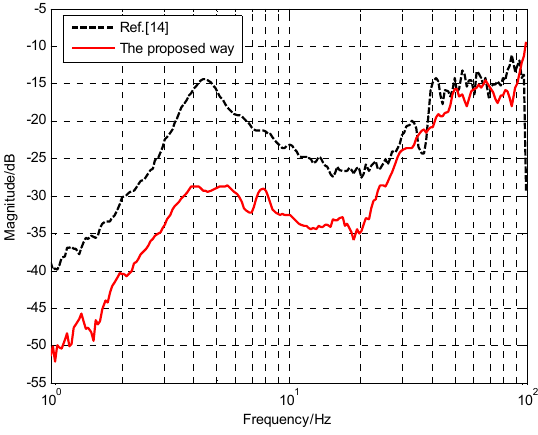
Figure 14. The DS’s comparison of Reference [14] and the proposed way.